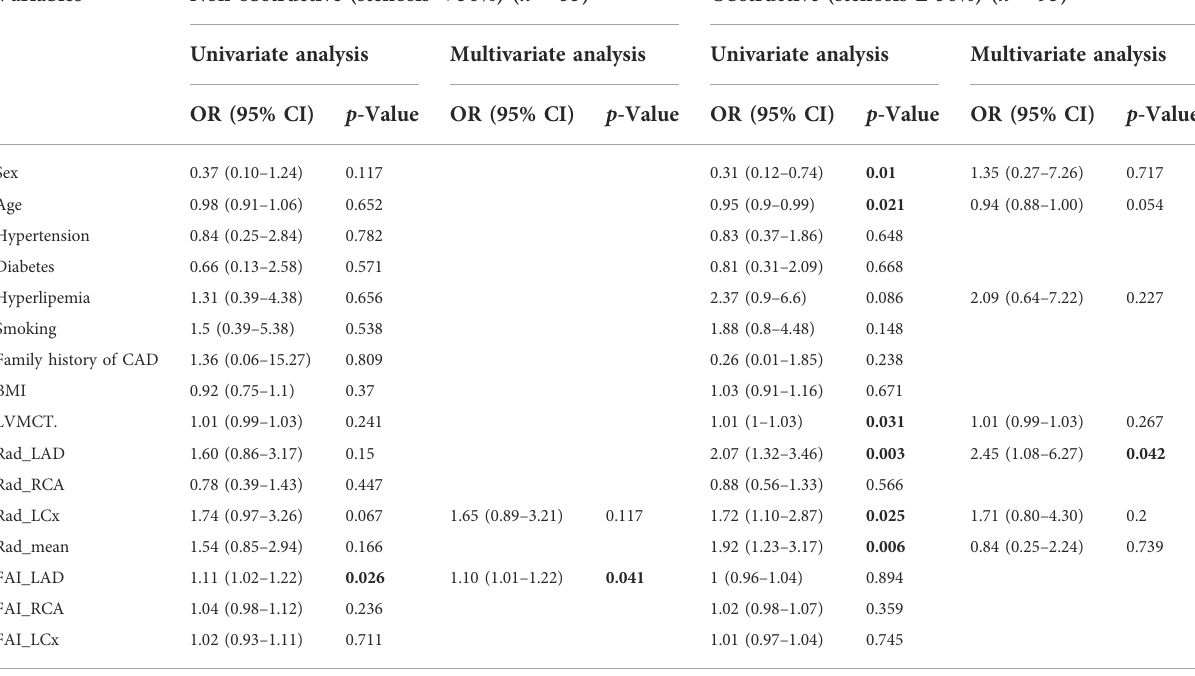
TABLE 5 Logistic regression analysis of discriminating coronary functional ischemia in subgroups divided by invasive coronary angiography in the testing group at the patient